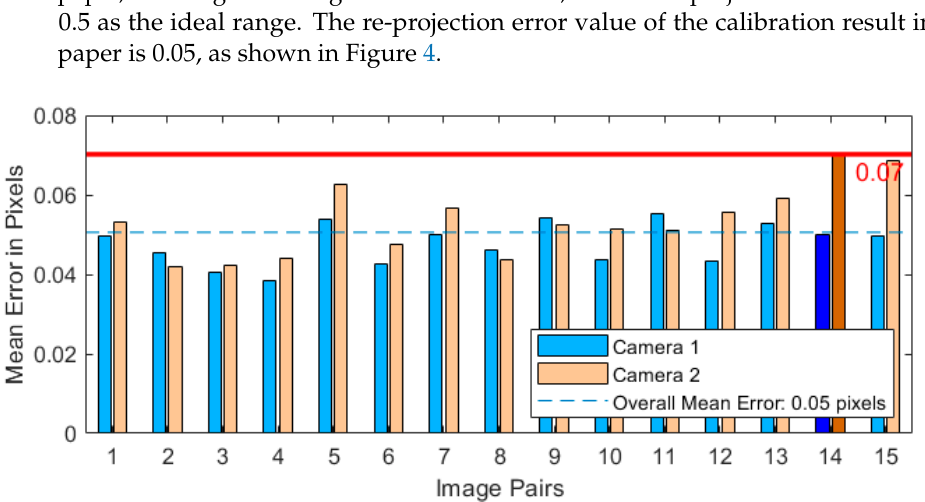
Figure 4. Re-projection Error.